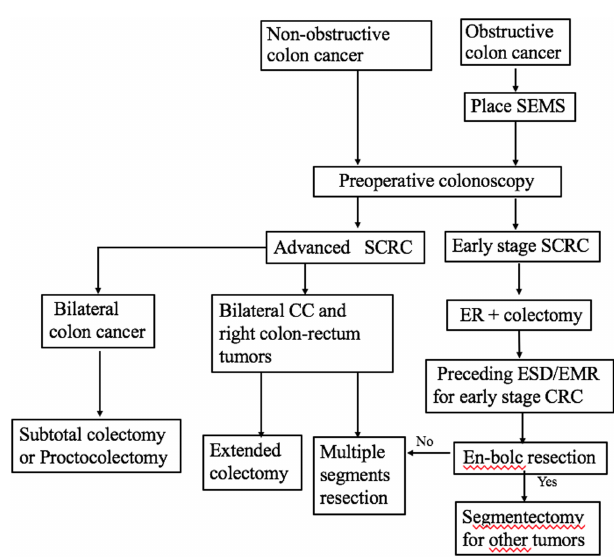
Figure 4. The treatment strategy in patients with SCRC. SCRC, synchronous colorectal cancer; SEMS, self-expanding metallic stent; ER, endoscopic resection; ESD, endoscopic submucosal dissection; EMR, endoscopic mucosal resection; CC, colon cancer; advanced SCRC, all colorectal tumors were diagnosed as advanced stage; early stage SCRC, at least one tumor was diagnosed as early